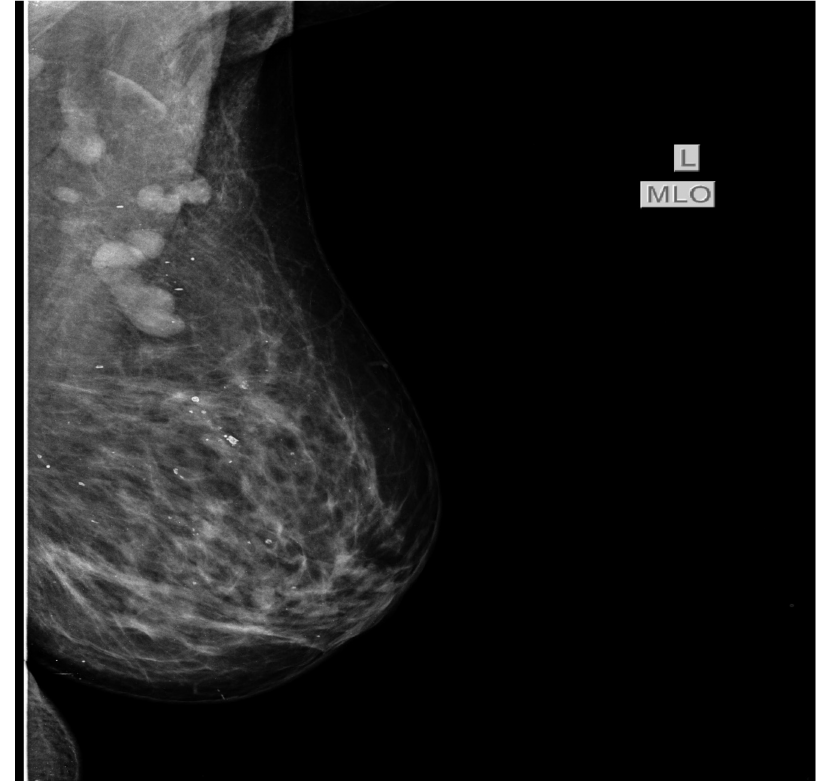
Figure 3. Bilateral mammography shows in the upper external quadrant of the left breast a density asymmetry, with multiple microcalcifications and associate multiple axillary adenopathies without the visualization of the fatty